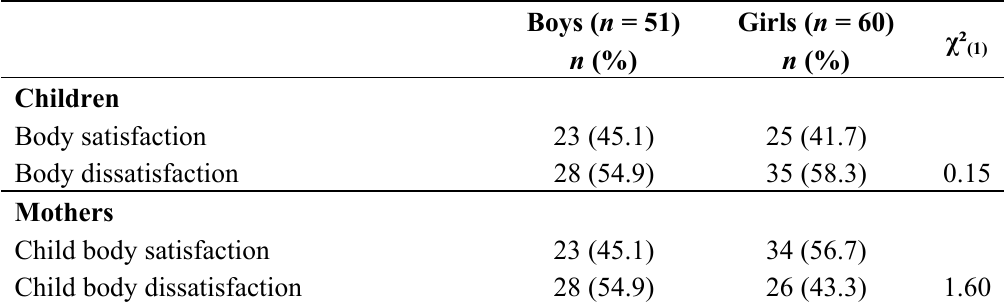
Table 1. Body dissatisfaction in boys and girls.